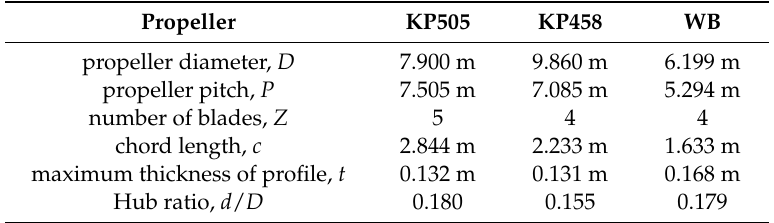
Figure 2. KP505 ( left ), KP458 ( middle ) and Wageningen series (WB) ( right ) propeller. Table 3. The main particulars of KP505, KP458 and WB.